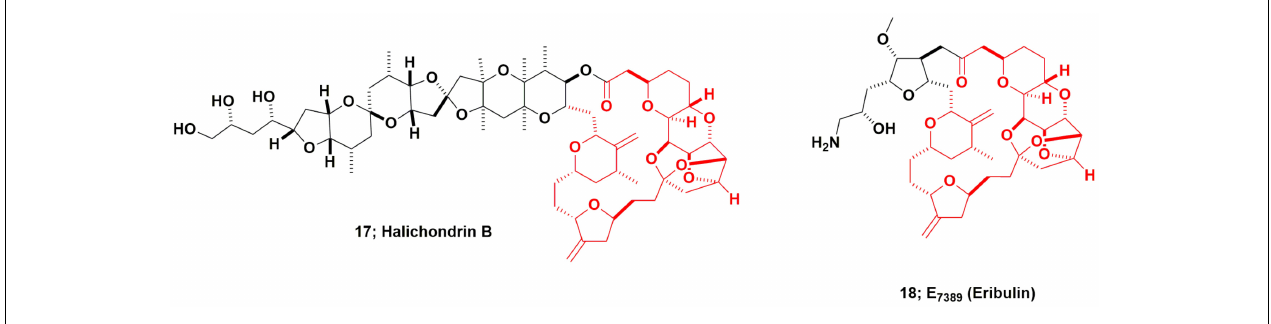
FIGURE 5 | Halichondrin B and